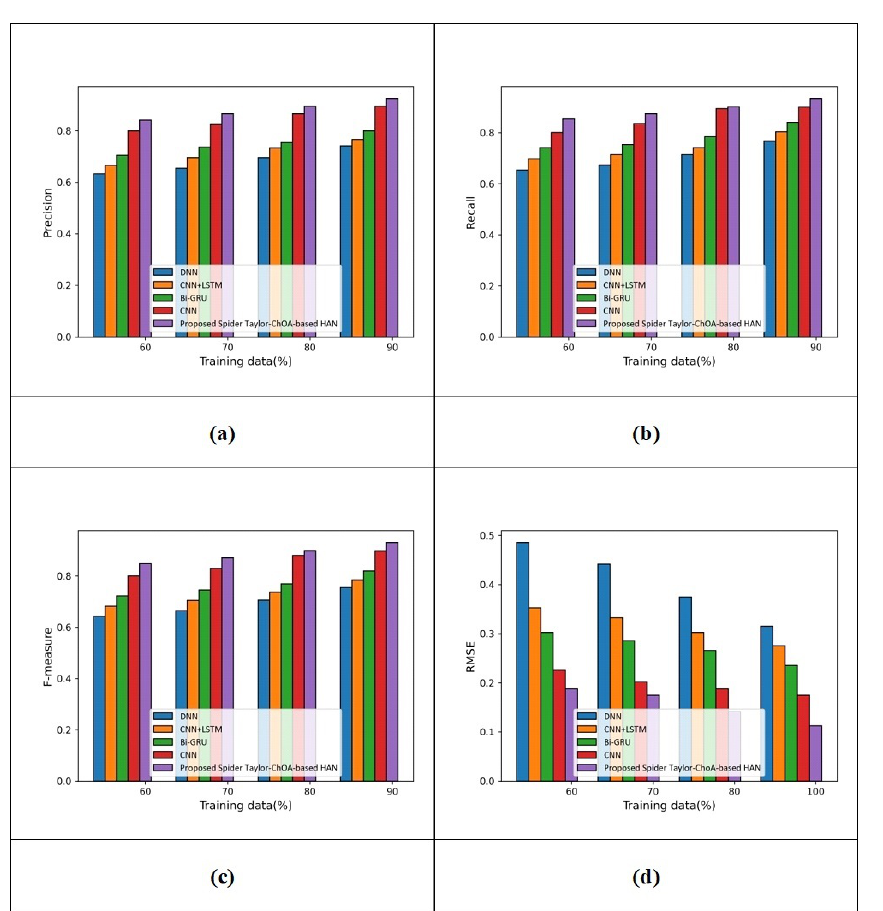
Figure 8. Results based on review rating prediction using Yelp 2013 datasets with ( a ) precision ( b ) recall ( c ) F-measure and ( d )